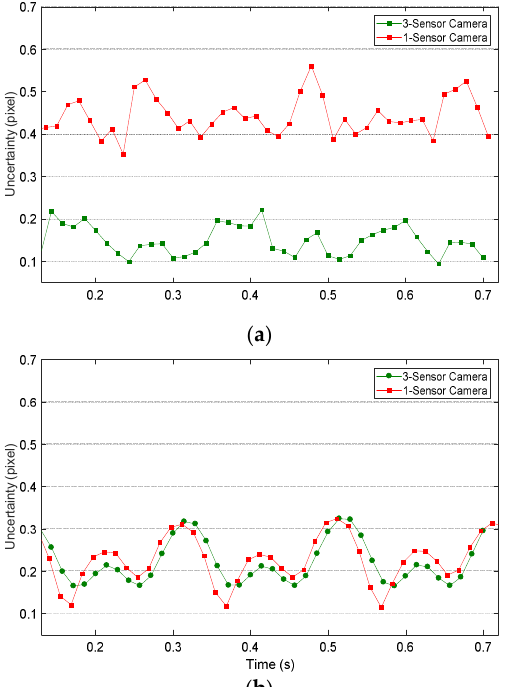
Figure 12. Standard deviation for in-plane displacement maps measured by 3-sensor camera (green) and 1-sensor camera (red) during vibration testing employing ( a ) an LCD projector and ( b ) a laser projector.